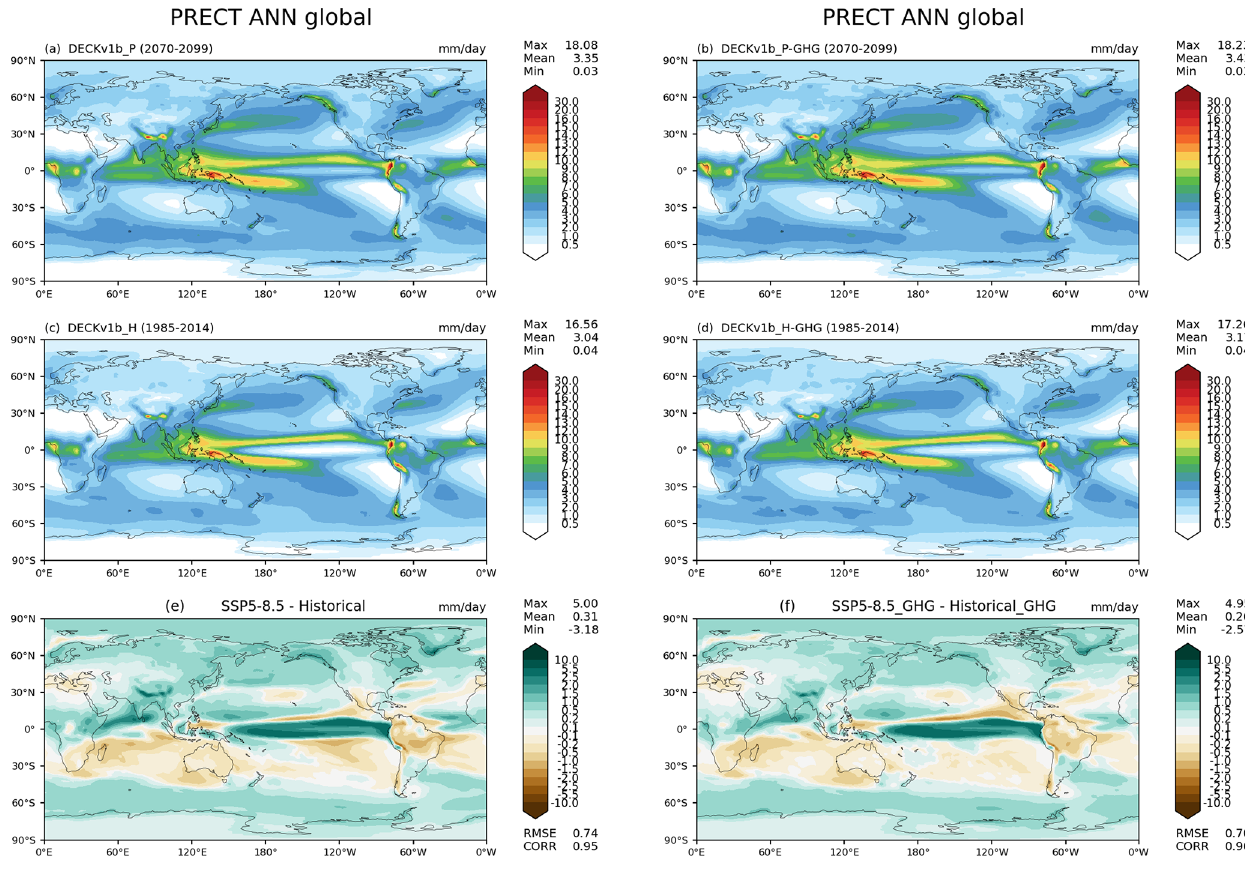
Figure 3. Annual mean precipitation rate (mmd − 1 ) from (a) five SSP5.85 ensemble simulations (2070–2099), (c) five historical ensemble simulations (1985–2014), and (e) the change between the time period of 2070–2099 and the period of 1985–2014. Annual mean precipitation rate (mmd − 1 ) from (b) three SSP5.85-GHG ensemble simulations (2070–2099), (d) three historical-GHG ensemble simulations (1985– 2014), and (f) the change between the time period of 2070–2099 and the period of 1985–2014.